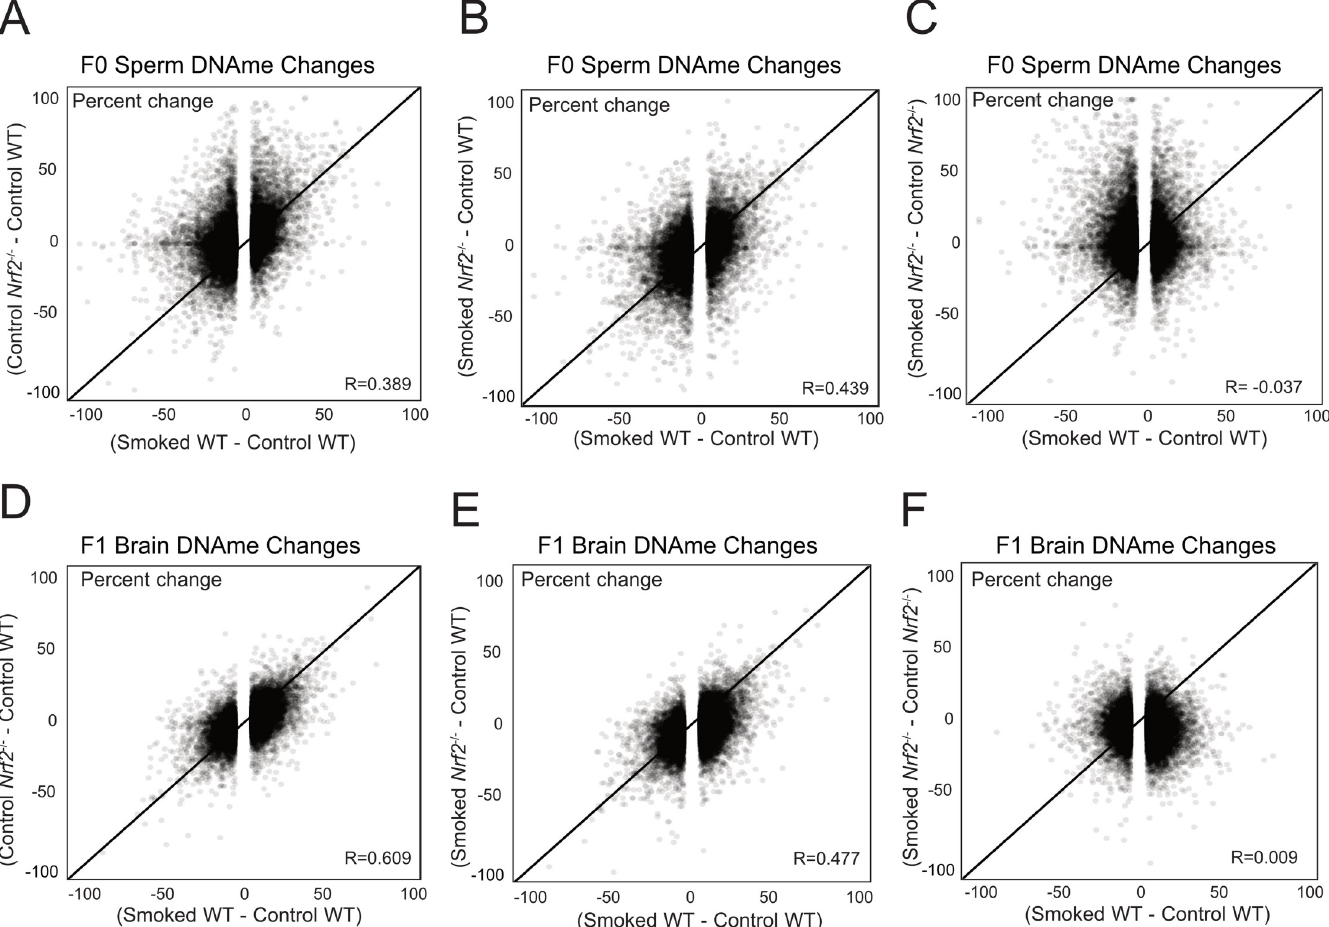
Fig 3. Differential methylation in F0 sperm and F1 prefrontal cortex. A) CS-induced DNAme changes in WT sperm displayed significant similarity to those in unexposed Nrf2 -/- sperm. B ) Similarly, sperm from CS-exposed Nrf2 -/- mice displayed DNAme patterns similar to those of CS-exposed WT mice. C ) However, the sperm DNAme changes in Nrf2 -/- mice that were attributable to CS-exposure were not associated to the CS-associated changes in WT sperm, suggesting that genotype in Nrf2 -/- mice is the primary driver of DNAme change in regions impacted by CS in WT mice. D) A highly significant correlation was observed in F1 brain DNAme changes induced by CS exposure in WT sires (x-axis) compared with DNAme changes associated with paternal Nrf2 status, even in the absence of CS-exposure. E) A similar correlation in DNAme change was observed in the offspring of CS-exposed Nrf2 +/- mice. F) The correlation disappeared when evaluating differential methylation in Nrf2 +/- offspring based on CS exposure status compared with CS-associated DNAme changes in offspring sired by WT mice.